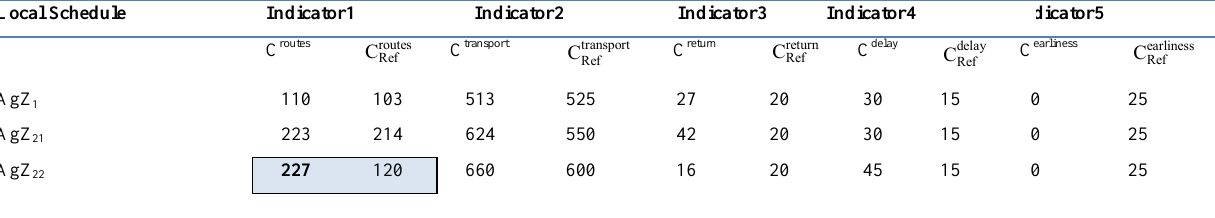
Table 4. Performance indicators values